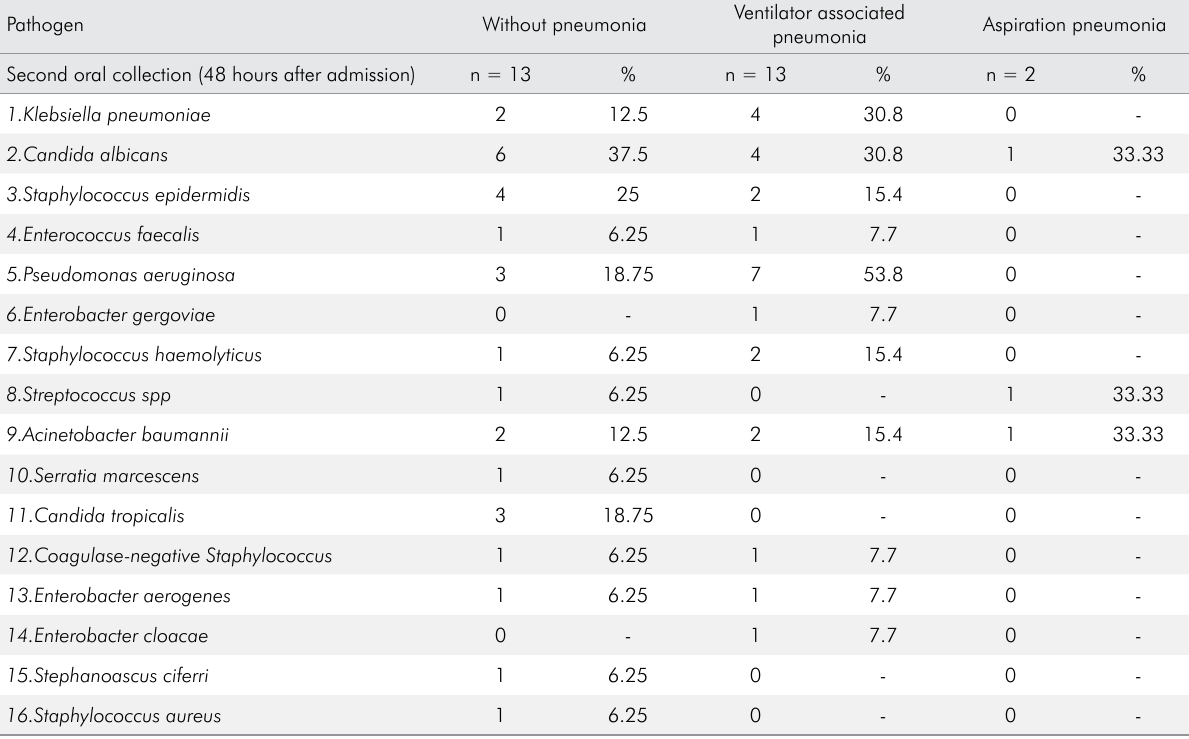
Table 3. Distribution of pathogens identified in the second (48 h) oral collection of patients on mechanical ventilation in the adult intensive care unit according to the pulmonology evolution of the